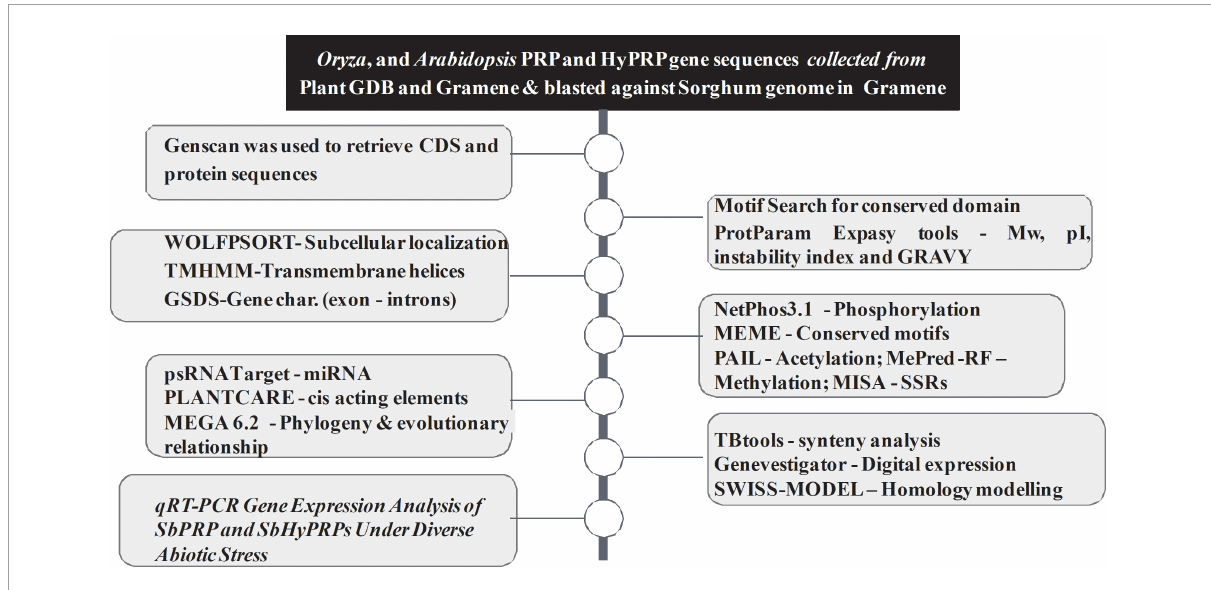
FIGURE1 Methods, softwares, and pipelines used for genome-wide screening and characterization of SbPRPs and SbHyPRPs.